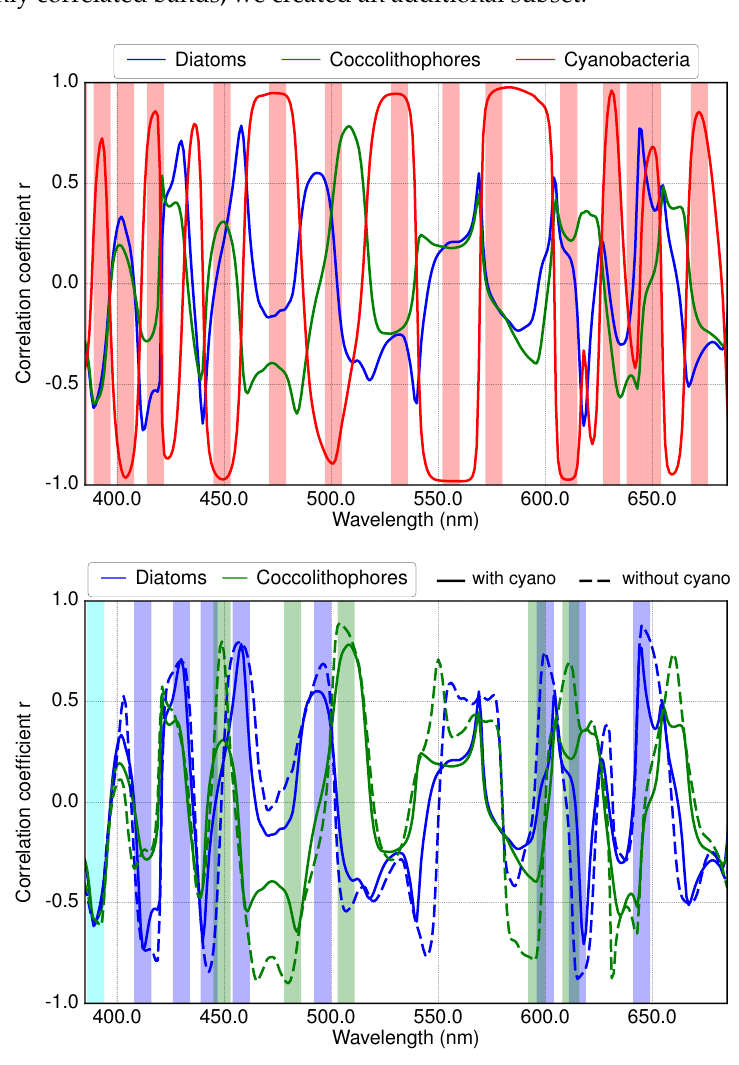
Figure 5. Correlation coefficients between the chl-a concentration of diatoms, coccolithophores and cyanobacteria and the second derivative spectra of normalized absorption coefficients of simulated mixtures. Highlighted areas indicate recommended spectral bands: red for cyanobacteria (top), blue and green for diatoms and coccolithophores, respectively (bottom). The color of the most left band in the bottom panel arises from the overlapping of both green and blue